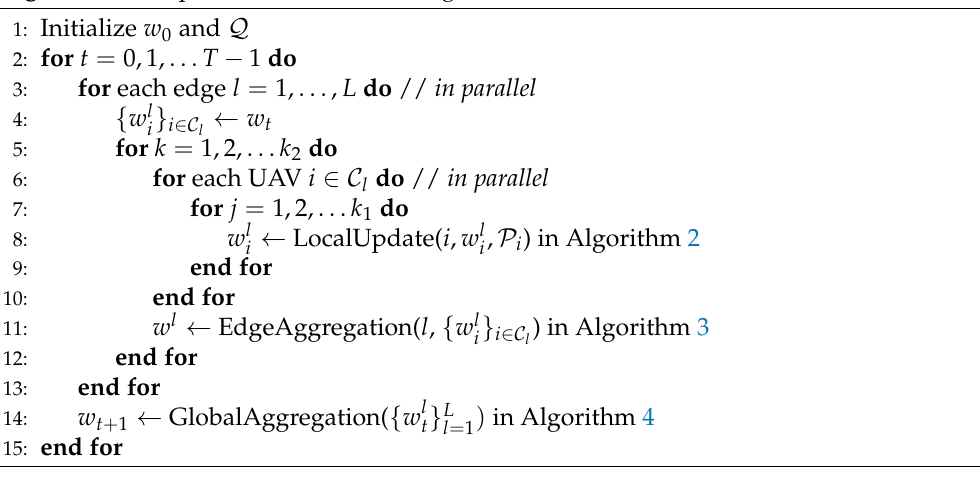
Algorithm 1 Proposed hierarchical FL algorithm.